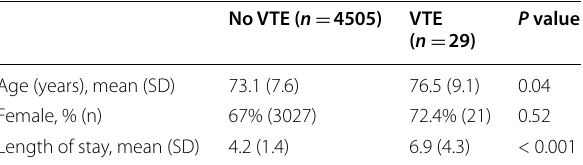
Table 2 Demographics and length of stay associated with incidence of VTE